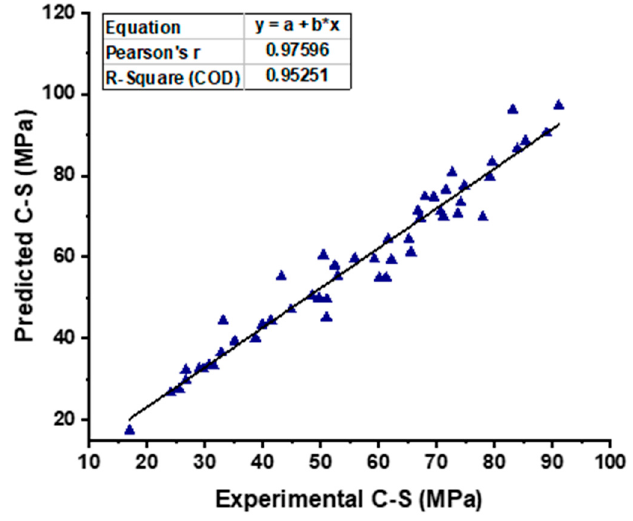
Figure 13. Experimental and predicted outcomes relationship of CS from BR model.